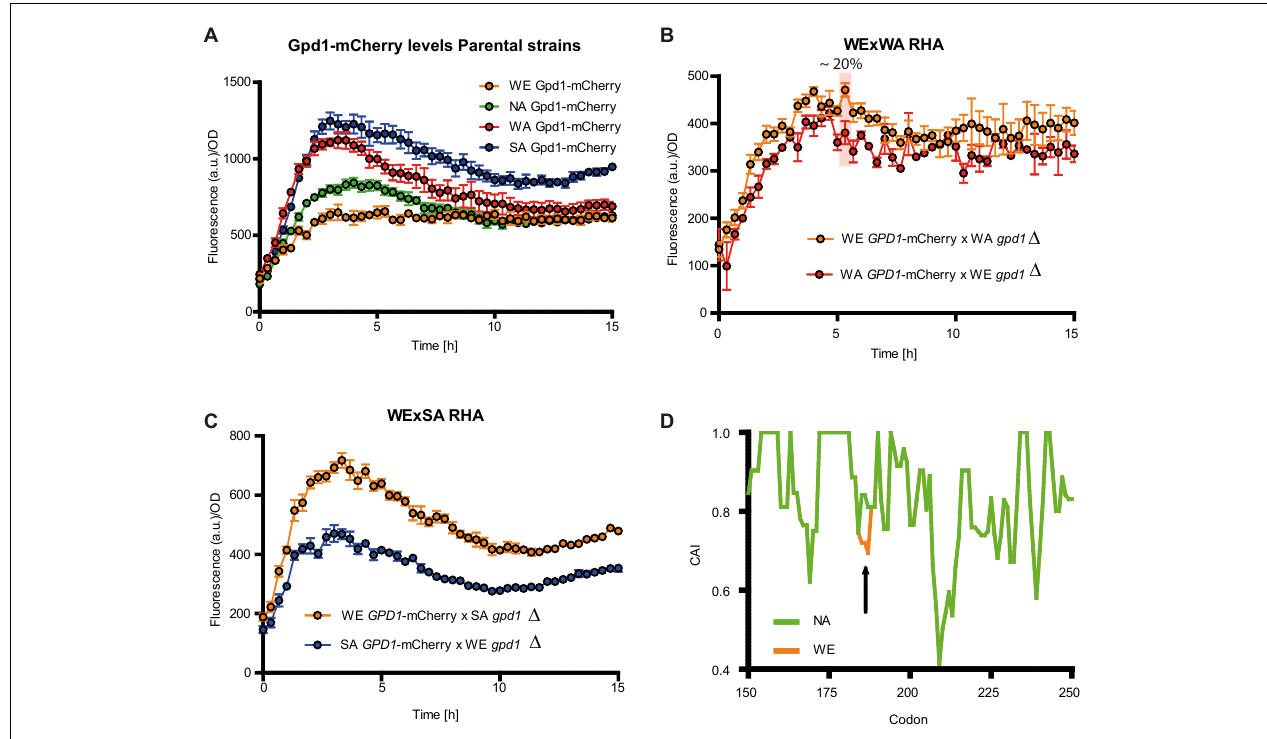
FIGURE 5 | Gpd1p levels in S. cerevisiae strains. Gpd1-mCherry levels in (A) parental strains, (B) WE × WA reciprocal hemizygotes, and (C) WE × SA reciprocal hemizygotes in micro cultivation in SWM. (D) Codon Adaptation Index (CAI) in NA, WA or SA strains (green) respect to the WE strain for GPD1 between codons 150 and 250. The arrow indicates the codon for which a CAI difference was found between GPD1 NA , GPD WA and GPD1 SA versus GPD1 WE